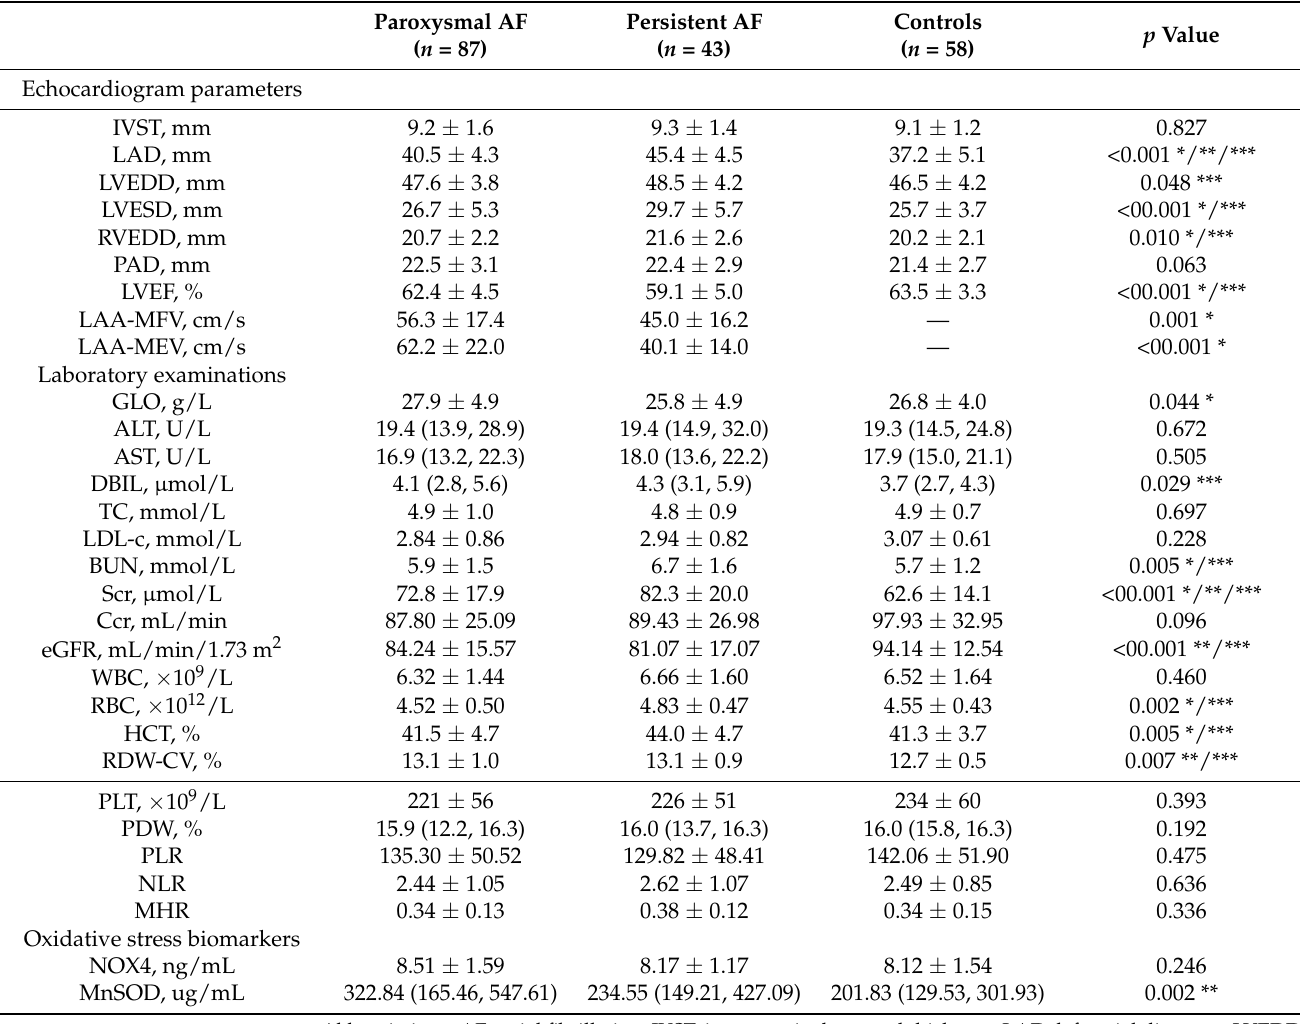
Table 2. Baseline laboratory and echocardiogram parameters of study